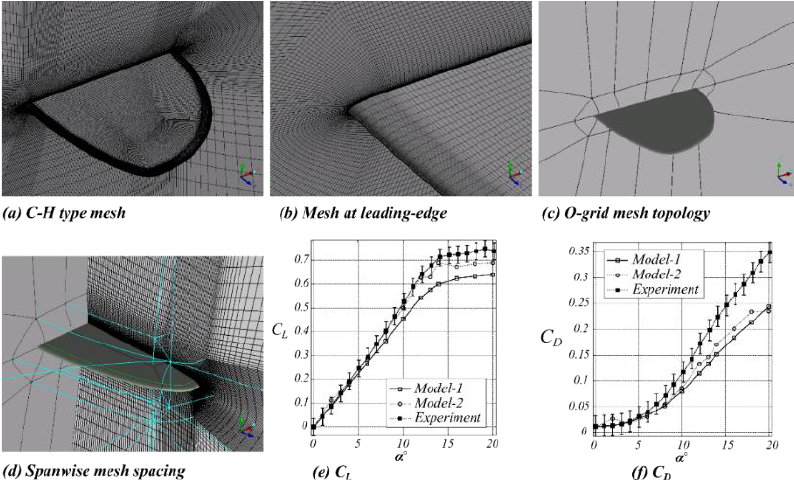
Figure 2. Mesh topology and aerodynamic coefficients for wing planform, (a) C-H mesh topology, (b) mesh at leading-edge, (c) O-grid mesh topology, (d) spanwise mesh spacing, (e) lift coefficient, (f) drag coefficient.